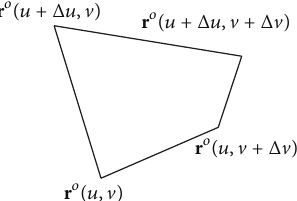
Figure 3: The area element of r 𝑜 (𝑢, V )